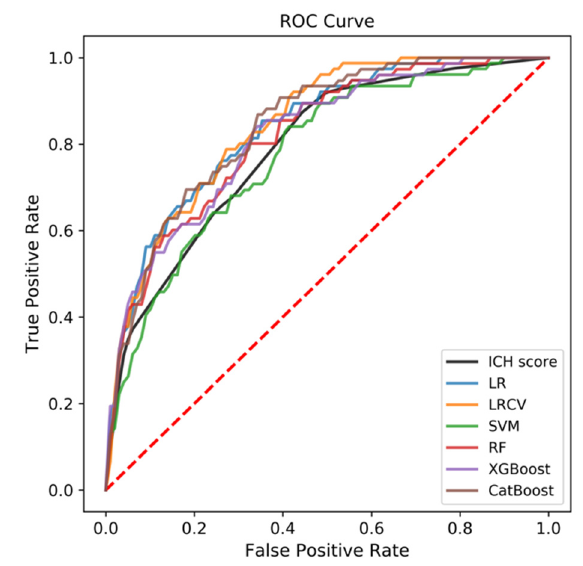
Figure 3. The ROC curve of all the six ML-based models compared with the traditional ICH Score, with respect to predictive performance for the 90-day mortality at the third month. Table 2. Predictive performance for the 90-day functional outcome and mortality after spontaneous intracerebral hemorrhage.